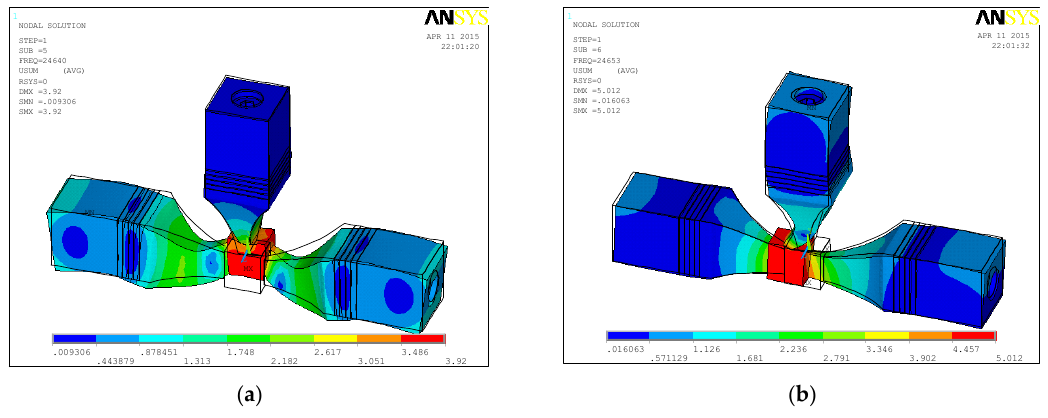
Figure 2. Two operating modes, A and B, of the stator: ( a ) Mode A; ( b ) Mode B.